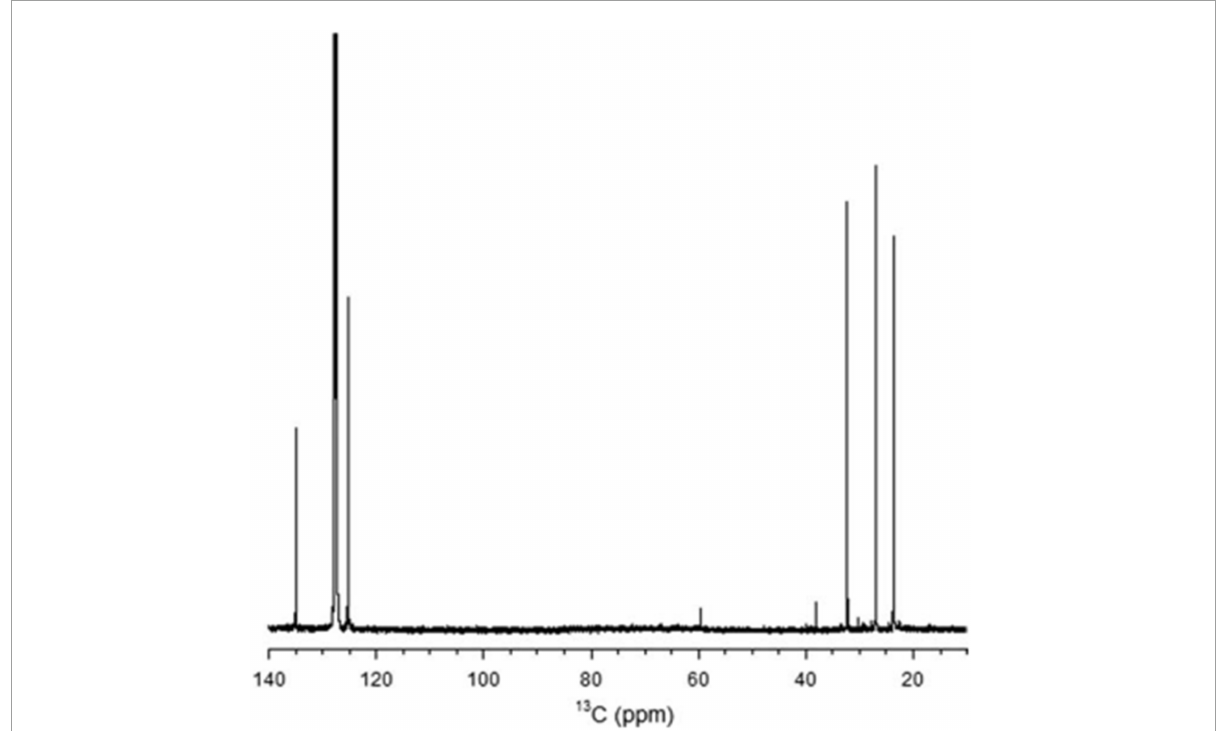
FIGURE10 The 13 C NMR spectrum of rubber extracted from E. characias latex. The peaks at 135.2,125, 32.2, 26.4, and 23.4 arises from the two ethylenic, two methylenic, and the methyl carbon atoms of the cis-1,4-polyisoprene, respectively (Spanò et al., 2012).